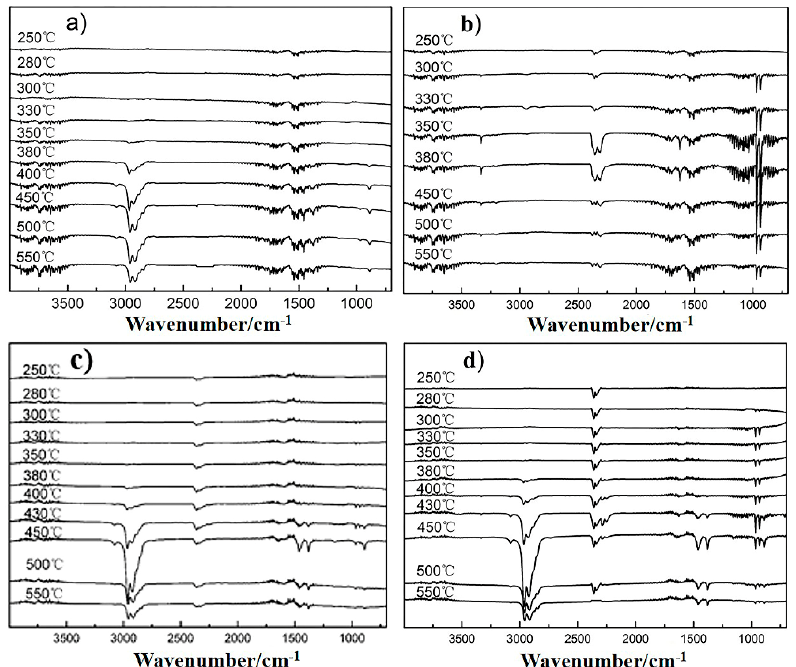
Figure 11. Volatile gases spectra measured by TG-FTIR for mPP fiber ( a ), modified Dohor-6000A ( b ), mPP-IFR-10 fiber ( c ) and mPP-IFR-25 fiber ( d ).